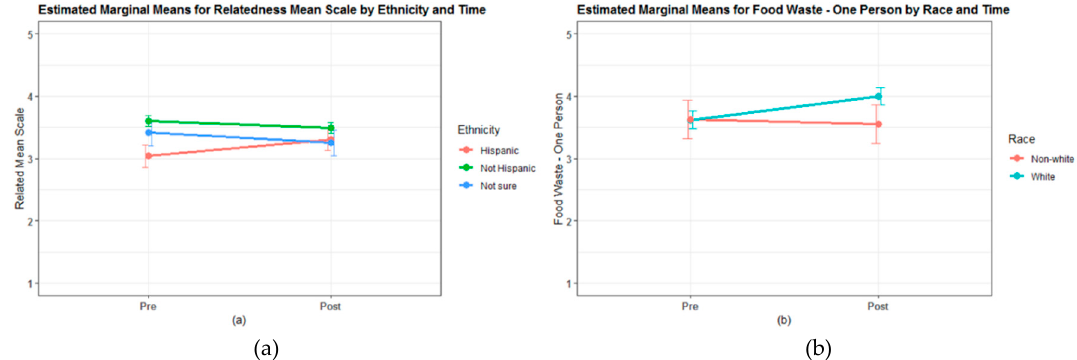
Figure 4. Interaction plots for ( a ) relatedness by time and ethnic group ( n = 78; averaged over levels of school, sex, race, how a student eats lunch, farm experience, garden experience, and cooking frequency) and ( b ) food waste question (“I feel that one person’s food waste is bad for the environment”) by time and race group ( n = 78; averaged over levels of school, sex, ethnicity, how a student eats lunch, farm experience, garden experience, and cooking frequency).